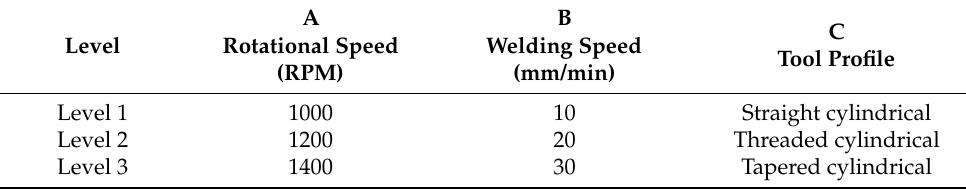
Table 1. Parameters values and their three levels.